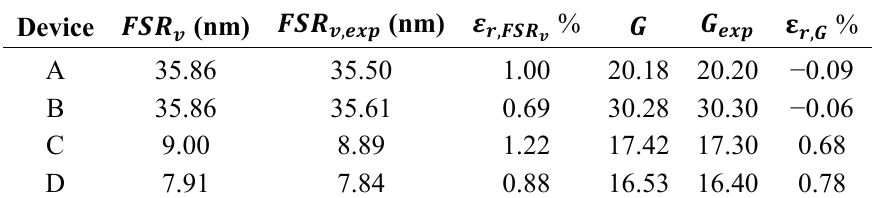
Table 4. Relative errors of FSRs and gains in the fabricated SOI Vernier